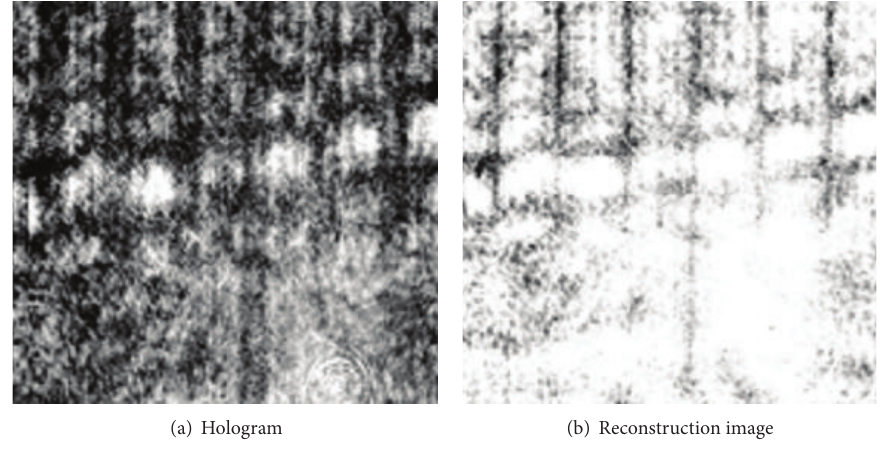
Figure 3: Hologram and reconstruction images of calibration target.